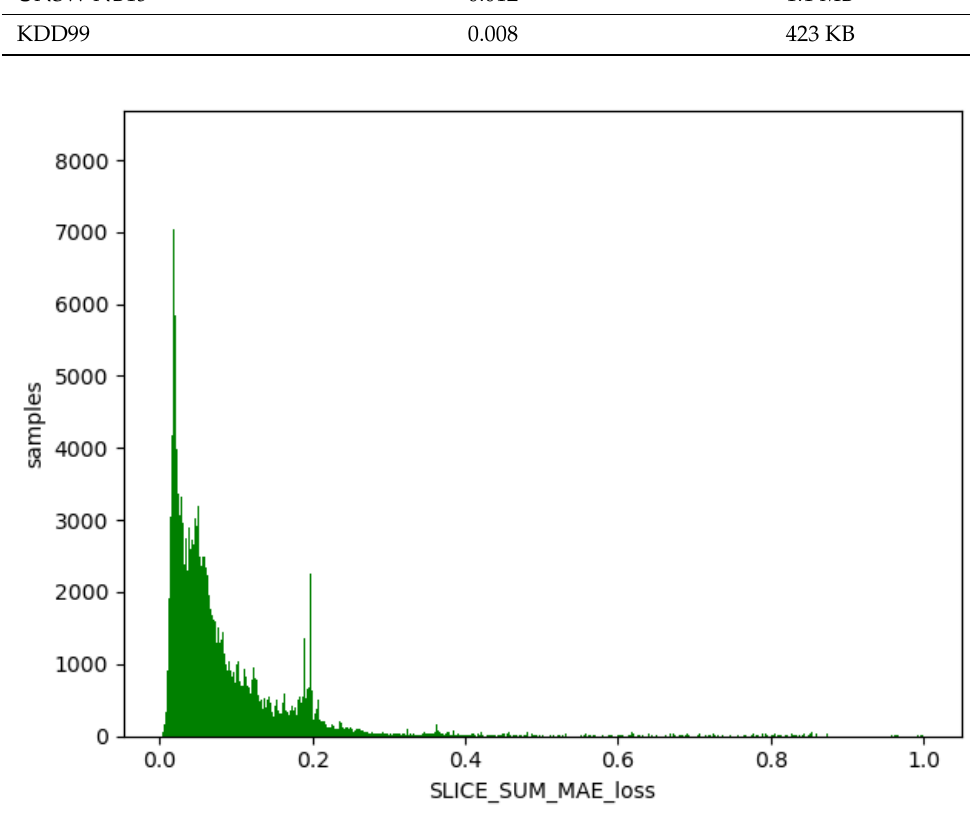
Figure 12. WSN-DS training set. Green indicates normal